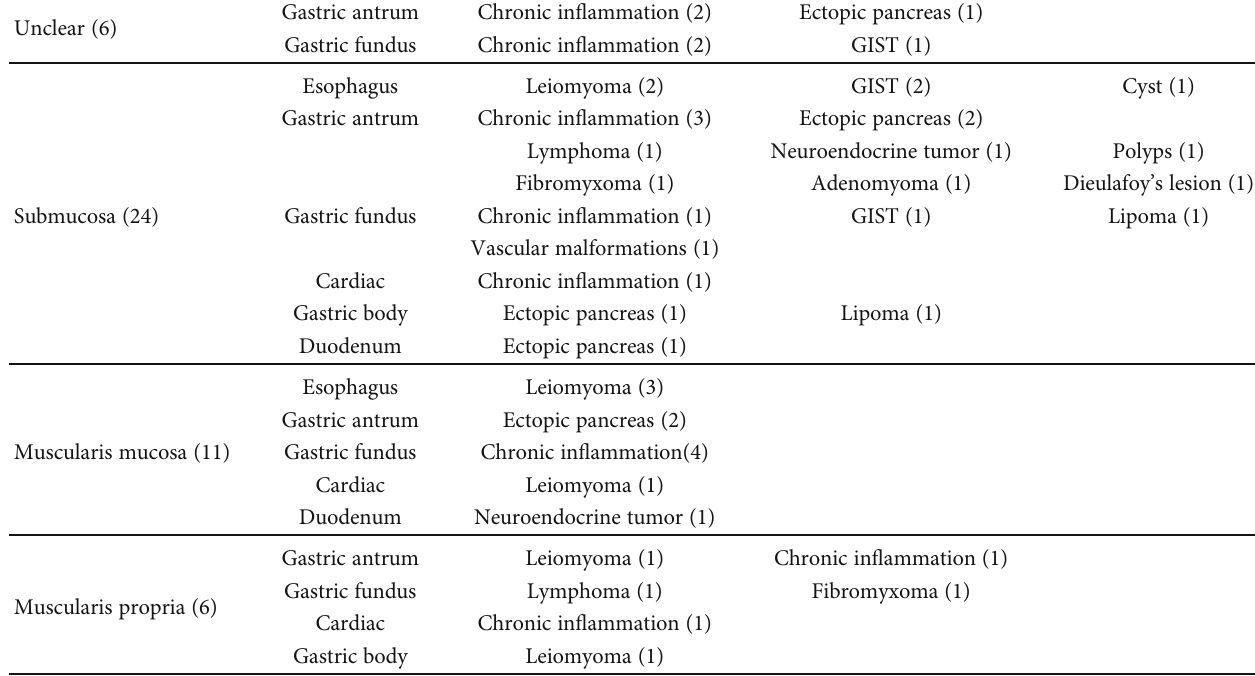
Table 6: Lesions undetermined by